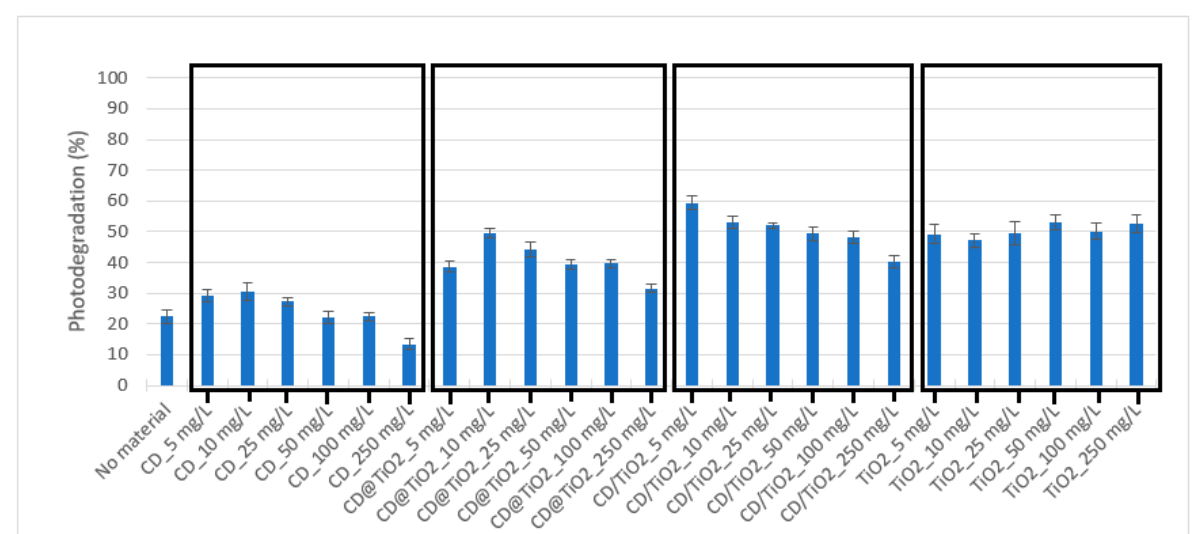
Figure 7. OXA (10 mg L − 1 ) photodegradation (%) after 1 h of simulated solar radiation in the absence and presence of photocatalysts at concentrations ranging from 5 to 250 mg L − 1 . Note: Error bars represent standard deviations ( n = 3).